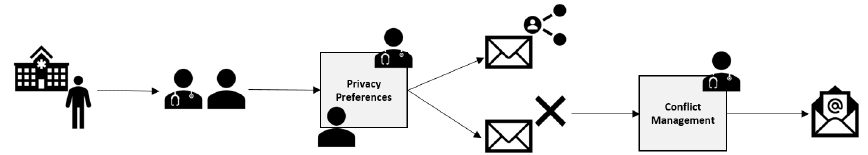
Figure 5. If the consultant and patient cannot resolve conflicts in access, an anonymized process that sends a letter to affected parties family doctor requesting additional testing can be generated and